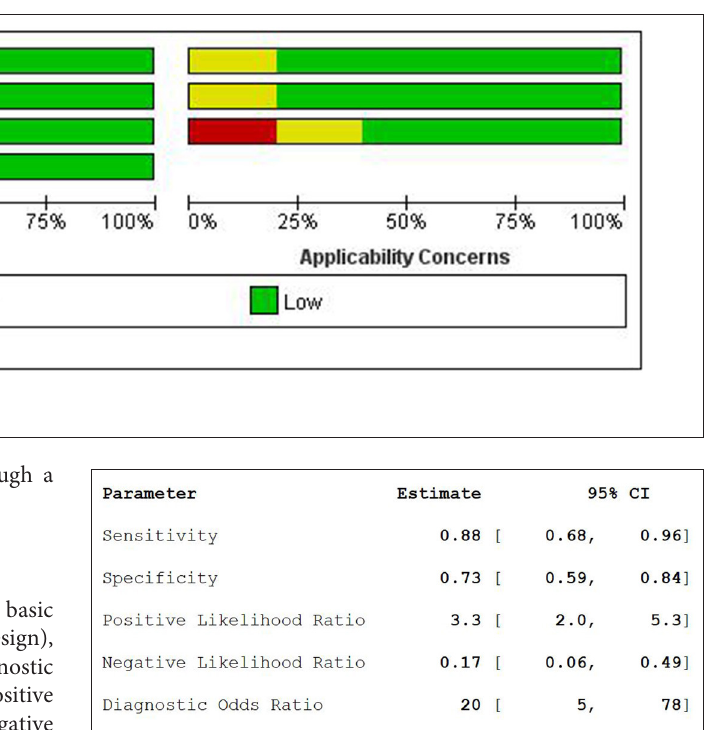
FIGURE 2 | The combined statistics CI, confidence interval.